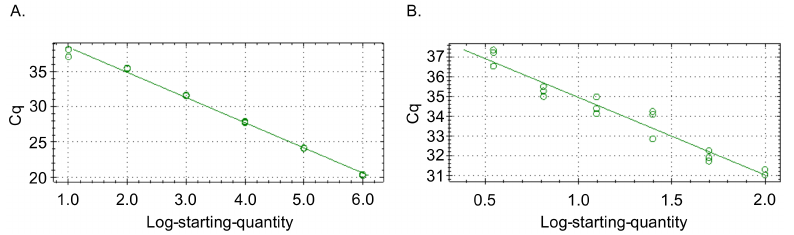
Figure 8. Primer set specific for O. tsutsugamushi OmpA is capable of amplifying low copy number ompA DNA standards. Standard curves generated by ompA -57F/260R amplification of ompA DNA standards diluted ten-fold from 1 × 10 6 to 1 × 10 − 2 ( A ) and from 100 to 3.5 copies ( B ). Data are representative of two experiments with similar results.